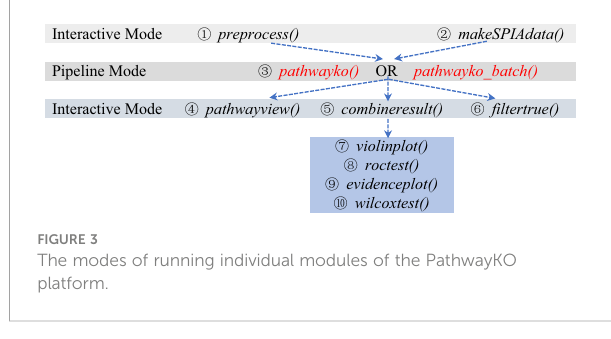
FIGURE 3 The modes of running individual modules of the PathwayKO